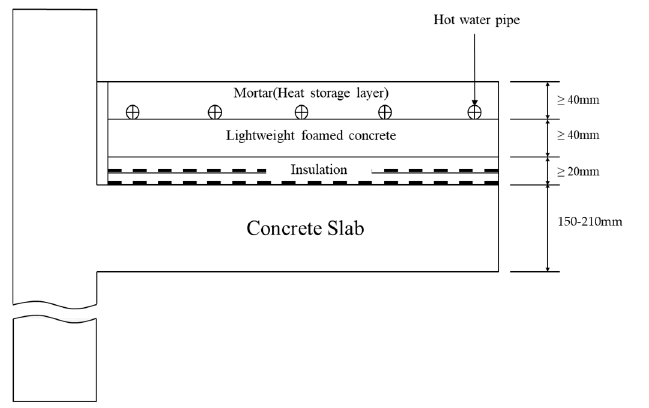
Figure 1. Construction standard of the bottom layer in Korea.